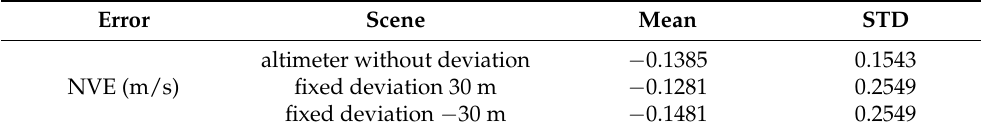
Table 6. Velocity error